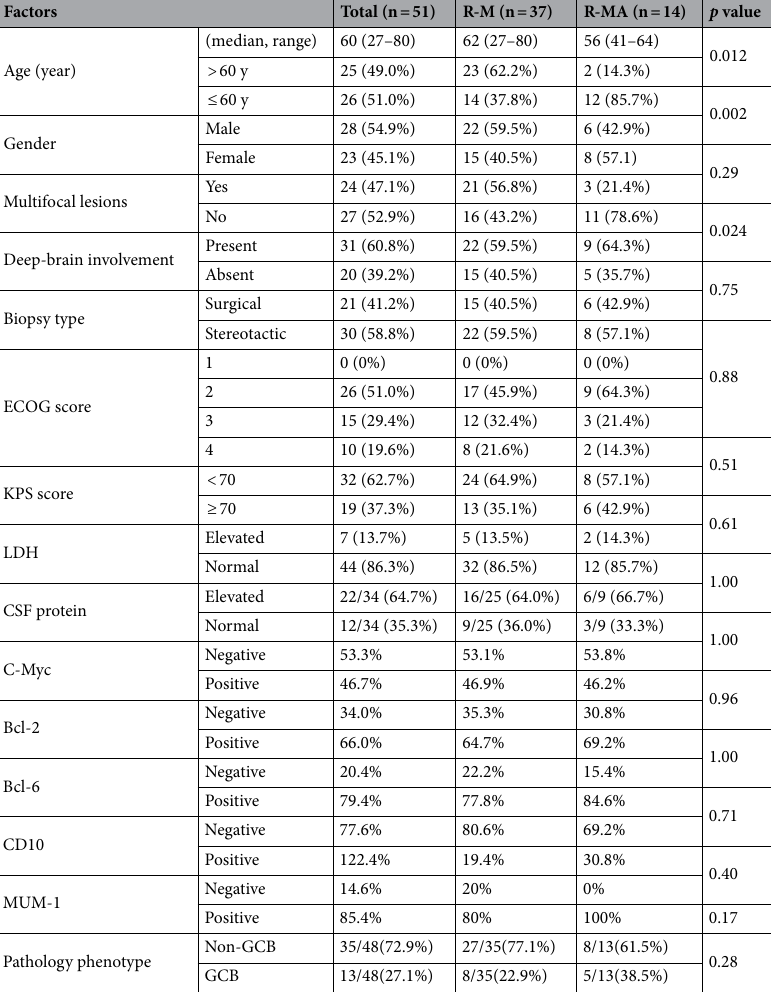
Table 1. Baseline patient characteristics and the distribution of lymphoma subtypes. Notes CSF, cerebrospinal fluid; ECOG, Eastern Cooperative Oncology Group; GCB, germinal center B-cell-like; KPS, Karnofsky performance status; LDH, lactate dehydrogenase; R-M, combination regimen of high-dose methotrexate and rituximab; R-MA, combination regimen of rituximab, high-dose methotrexate and